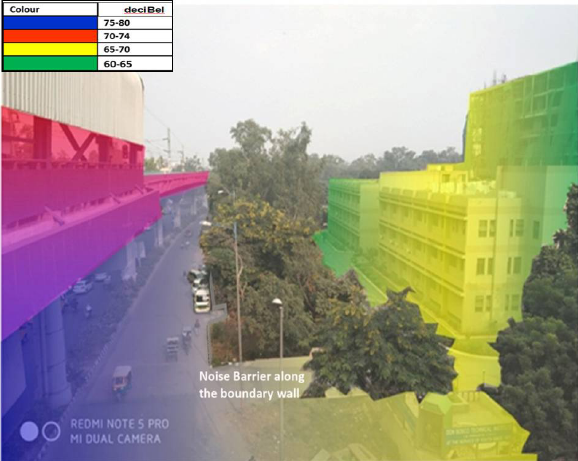
Figure 9: 3D noise mapping of Don Bosco Technical Institute area after installation of noise